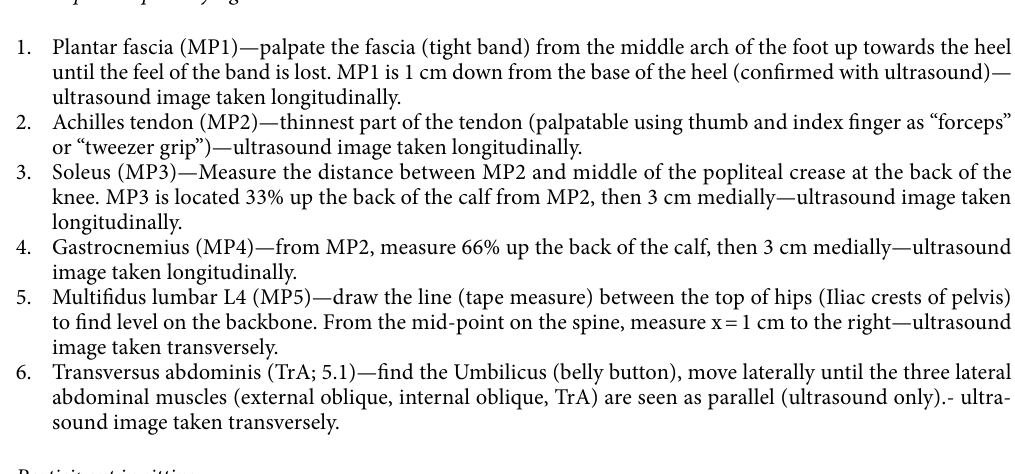
Measurement points. The MP for this study were based on those for the Myotones project currently ongo- ing on the ISS 24 , where both technologies are tested at 11 sites (seven of which are assessed in this study). All MPs (all on right side) can be seen below (Fig. 1). As some of the MPs listed below included in the Myotones study already have well established reliability, only seven measurement points were examined in the present study: MP1, MP2, MP3, MP6, MP7, MP9, and MP10. Participant in prone lying: with roller under the ankle.